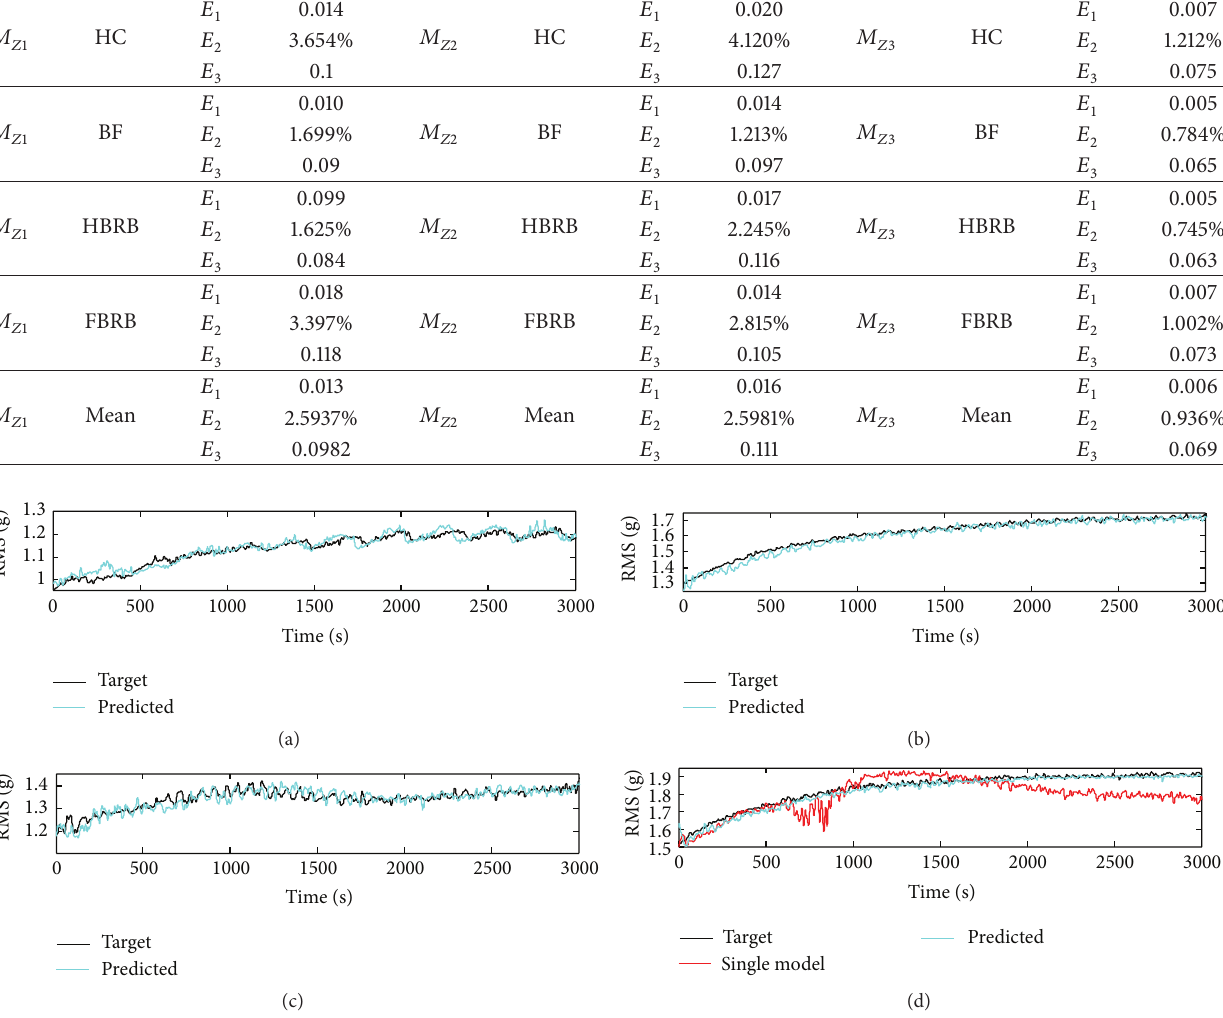
Figure 11: Results of the forecasting method. (a) Combined output applied to HC. (b) Combined output applied to HBRB. (c) Combined output applied to FBRB. (d) Combined output applied to BF versus the output of the single model method to the same scenario.